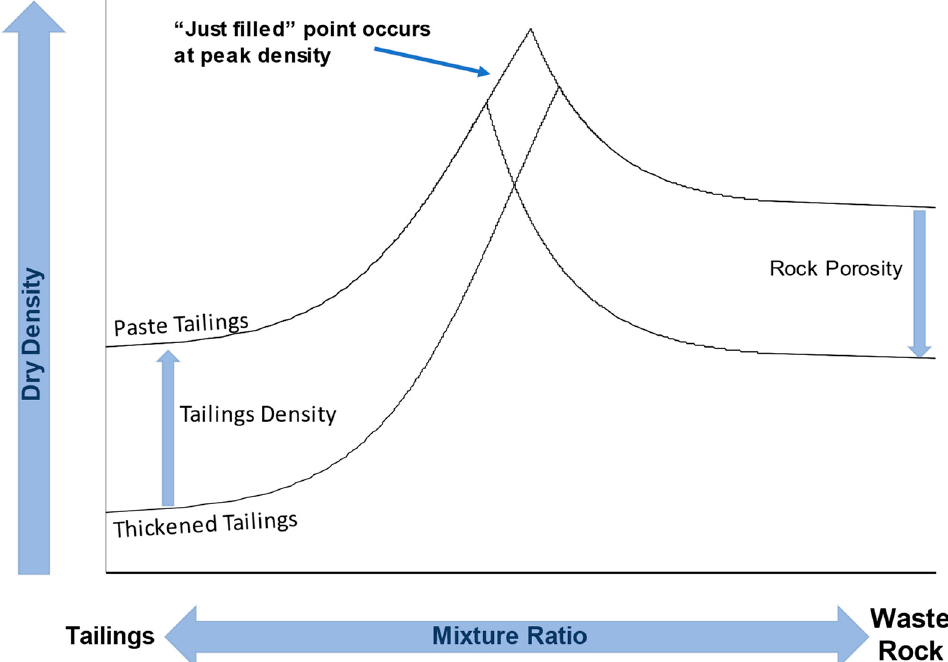
Figure 4. Mix design theory after Wickland et al. (2006)